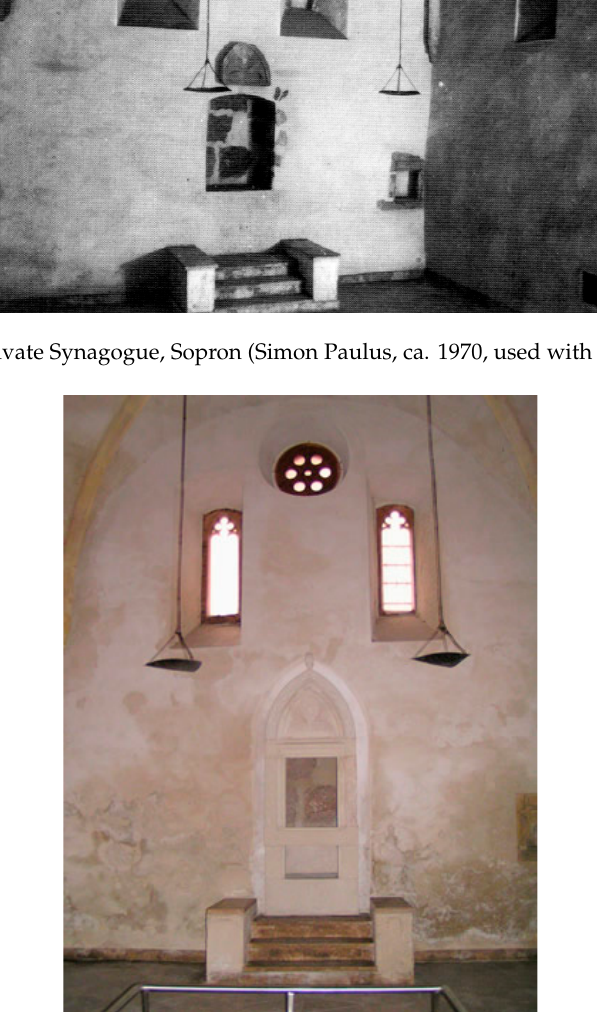
Figure 9. Private Synagogue, Sopron (Creative Commons).